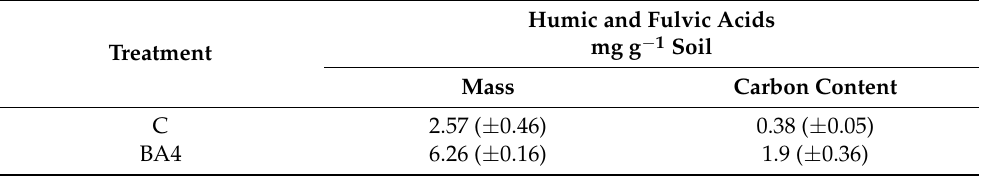
Table 5. Comparison of humic and fulvic acids and carbon masses between untreated (C) and bioaug- mented (BA4) soils after 8 months of incubation (mean value of quadruplicates ± standard